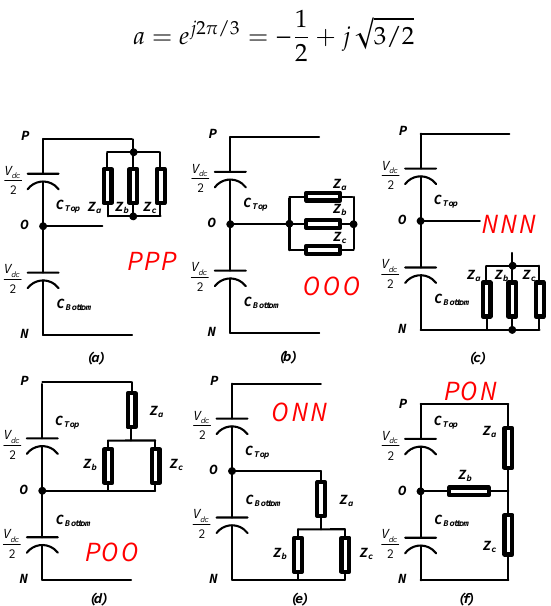
Figure 4. Voltage vector depending on the switching state: ( a ) PPP; ( b ) OOO; ( c ) NNN; ( d ) POO; ( e ) ONN; ( f ) PON.